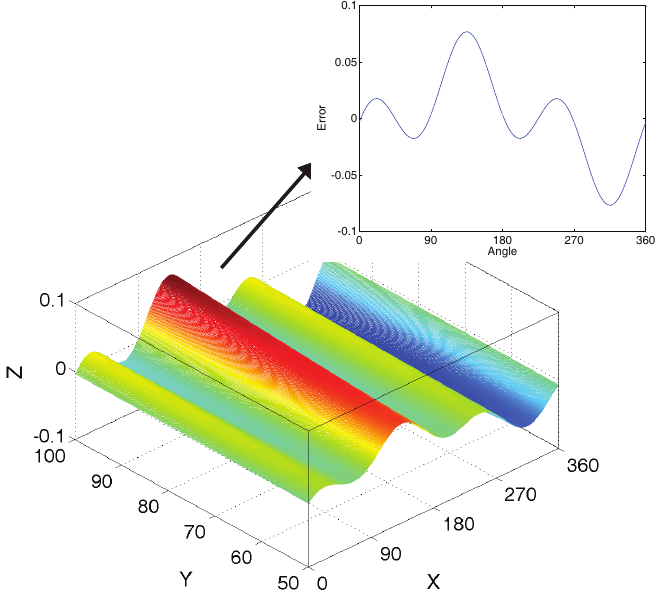
Figure 7. The angle error curve in non-linearity. The x -axis is the angle from 0 ◦ to 360 ◦ . The y -axis is the magnetic field intensity from 0 mT to 100 mT. The z -axis is the error.